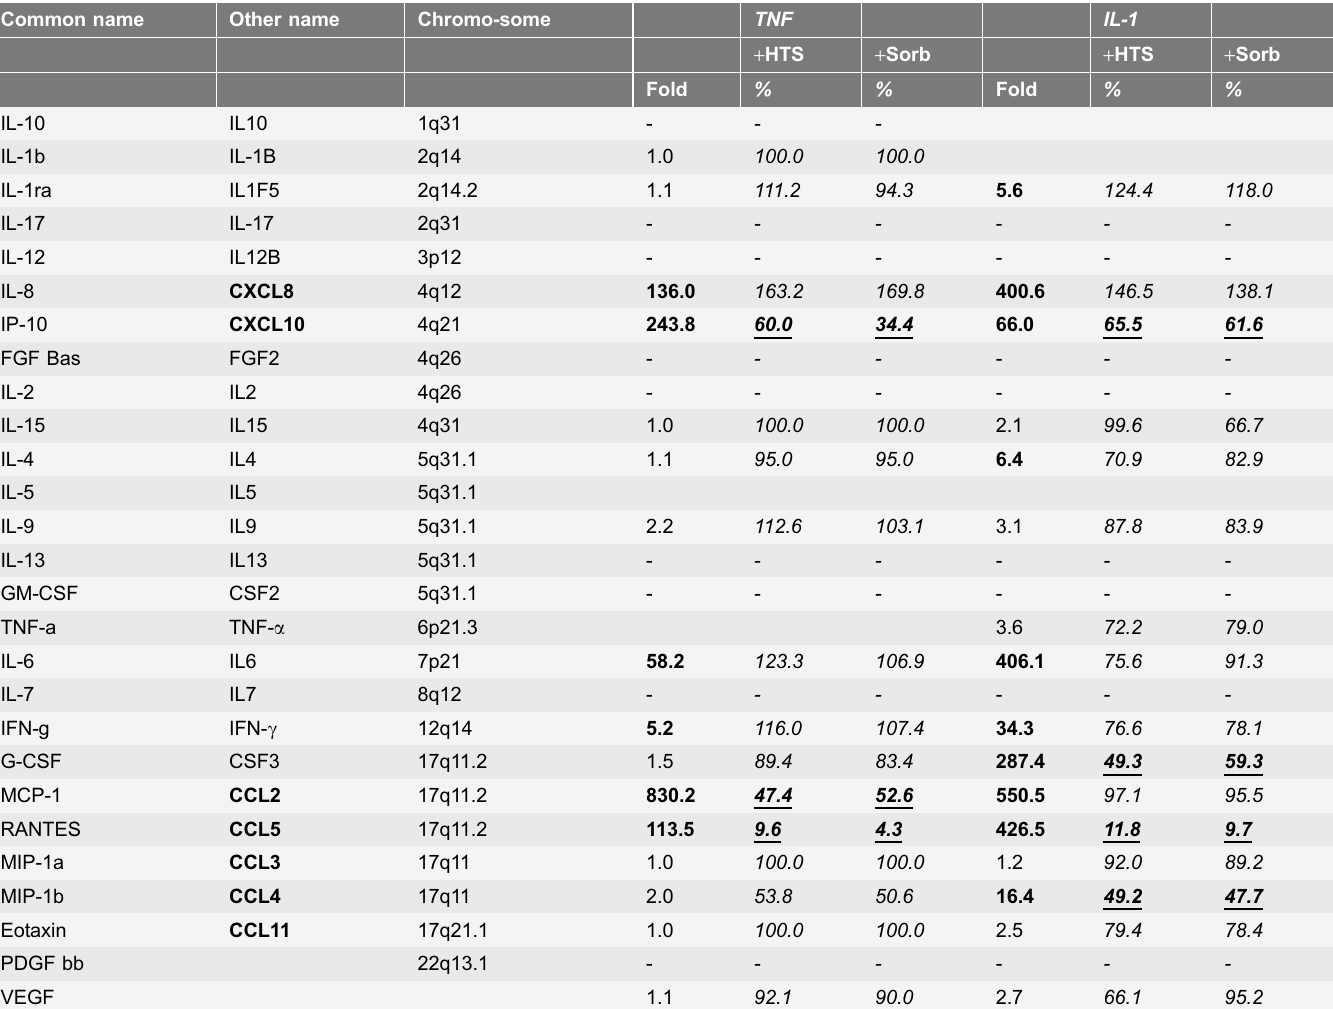
Table 1. Hyperosmolarity inhibits secretion of archetypal cytokines induced by TNF a or IL-1 b . Common